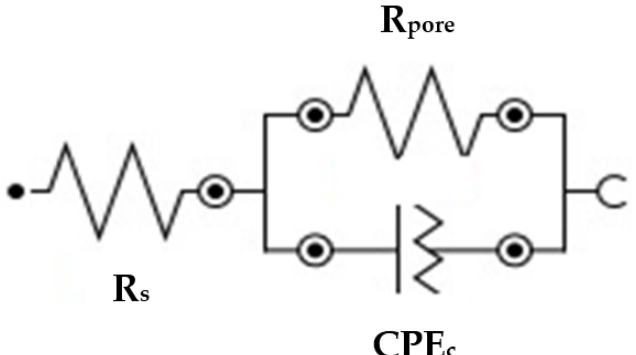
Figure 9. Electrochemical circuit of the corrosion process of Al coating in SAE J2334 solution with exposure periods. Table 5. Electrochemical parameters of Al coating extracted after the fitting of EIS data in a constant phase element (CPE) model with exposure periods in SAE J2334 solution.